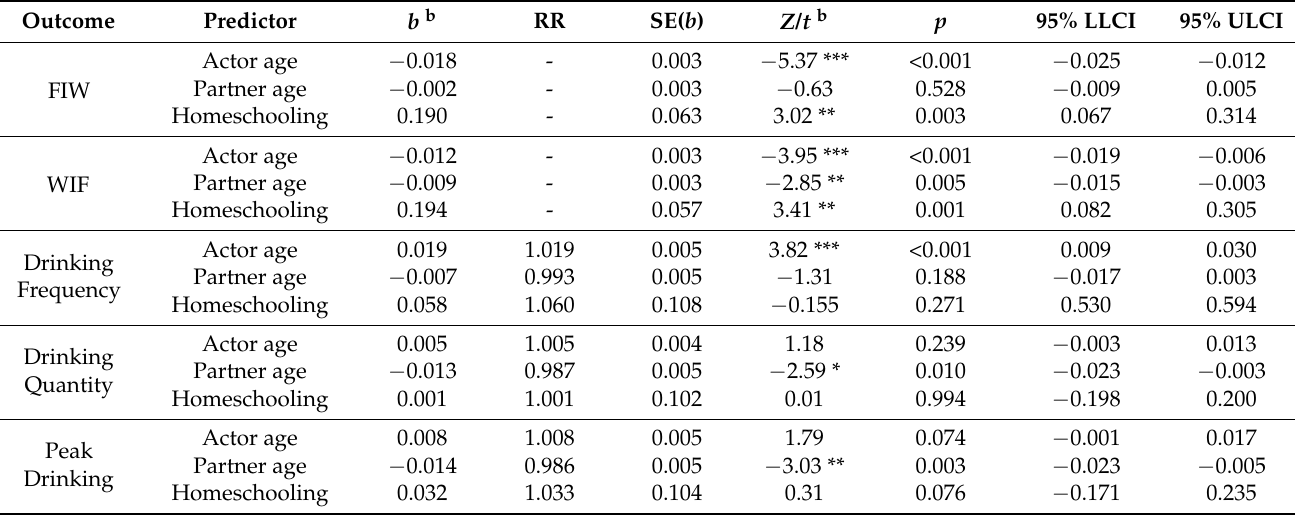
Table 3. Actor–Partner Interdependence Models (Indistinguishable) Examining Partners’ Effects of Homeschooling on Work Family Conflict and Alcohol Use.